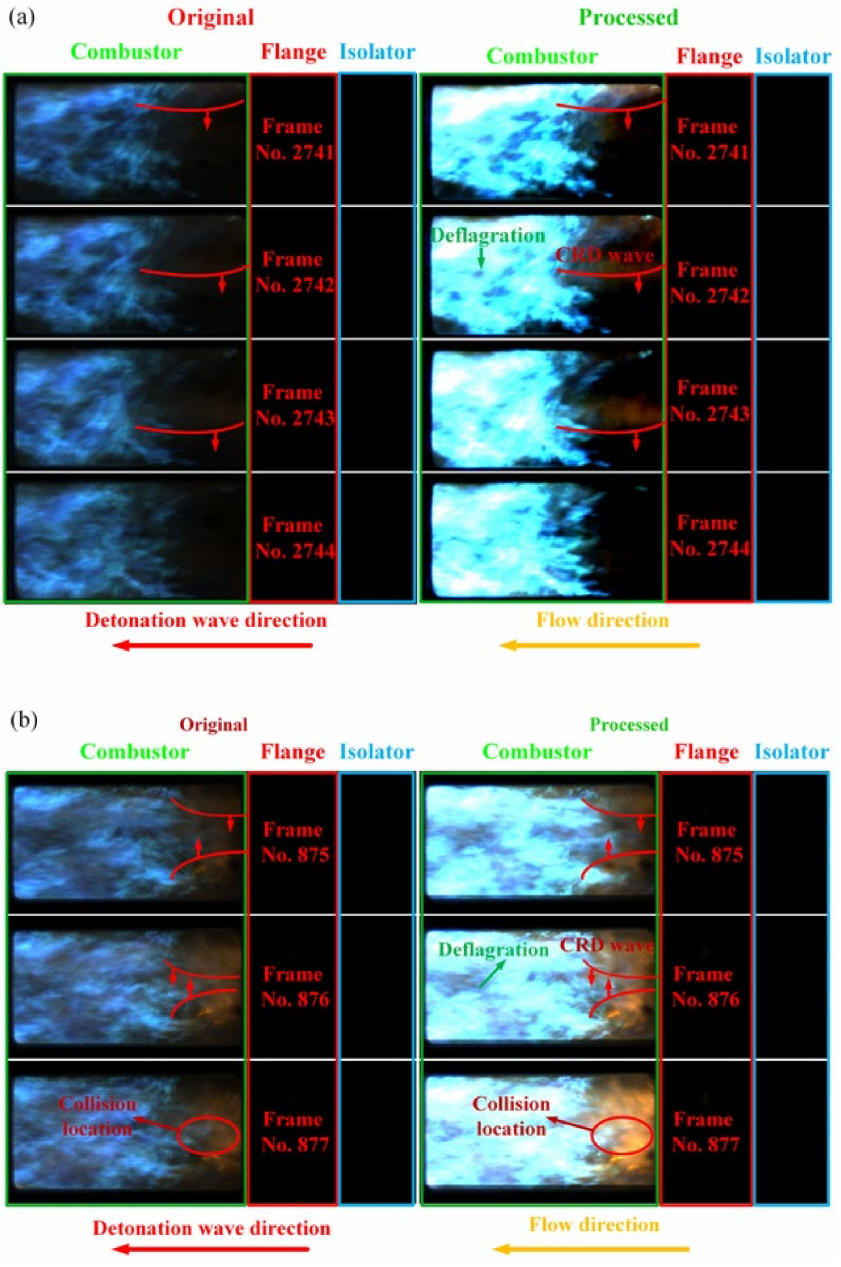
Figure 8. High-speed images of Case #1: ( a ) single wave; ( b ) two-wave